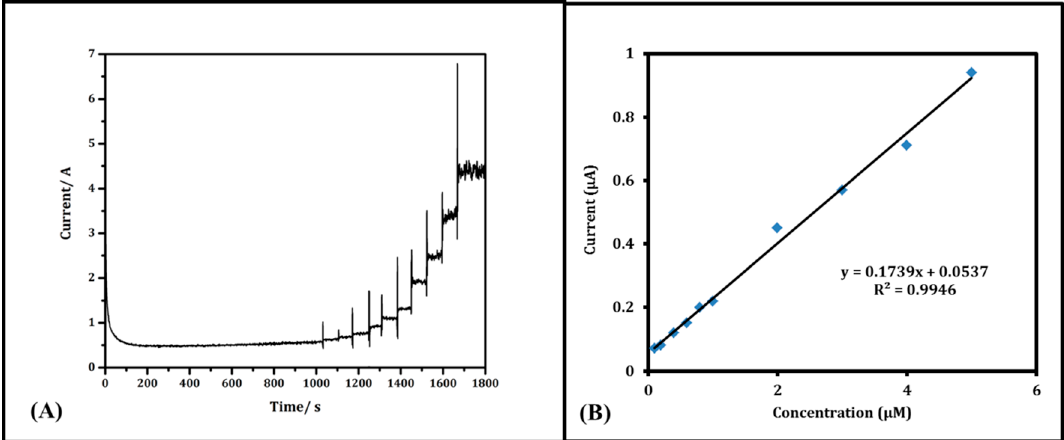
Figure 4. ( A ) Amperometric test of DA (0.1, 0.2, 0.4, 0.6, 0.8, 1, 2, 3, 4, and 5) µM in the presence of 10 µM of AA & UA each; ( B ) Calibration curve of corresponding DA concentrations plot vs. current response.